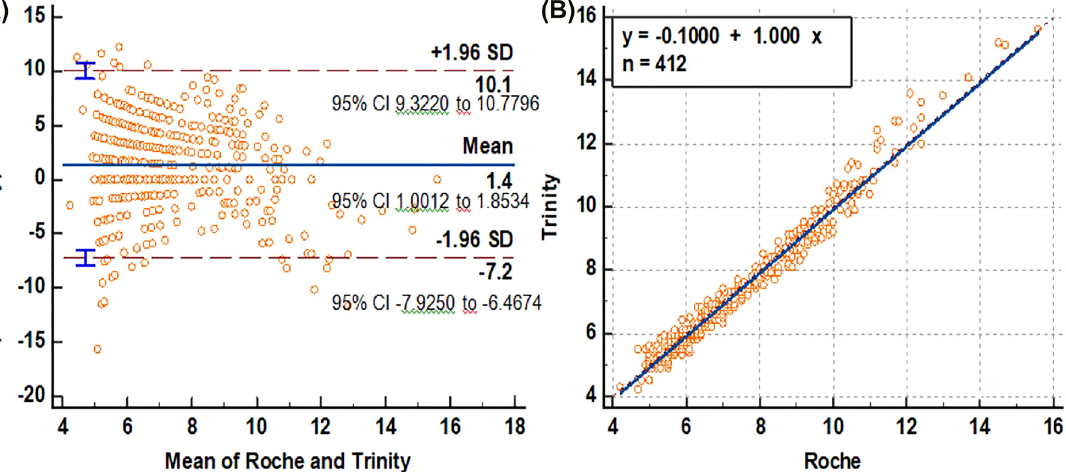
Figure 1: (A) Bland-Altman plot examination for calculating absolute difference between methods, (B) Passing-Bablok regression analysis of Trinity and Roche for HbA 1c